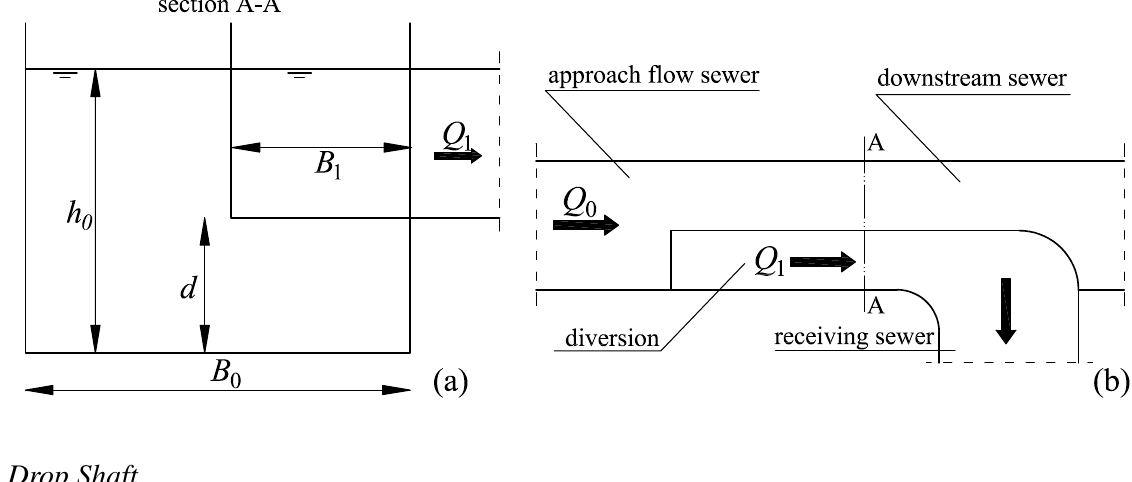
Figure 2. Diversion structure views: ( a ) cross-section and ( b ) plan